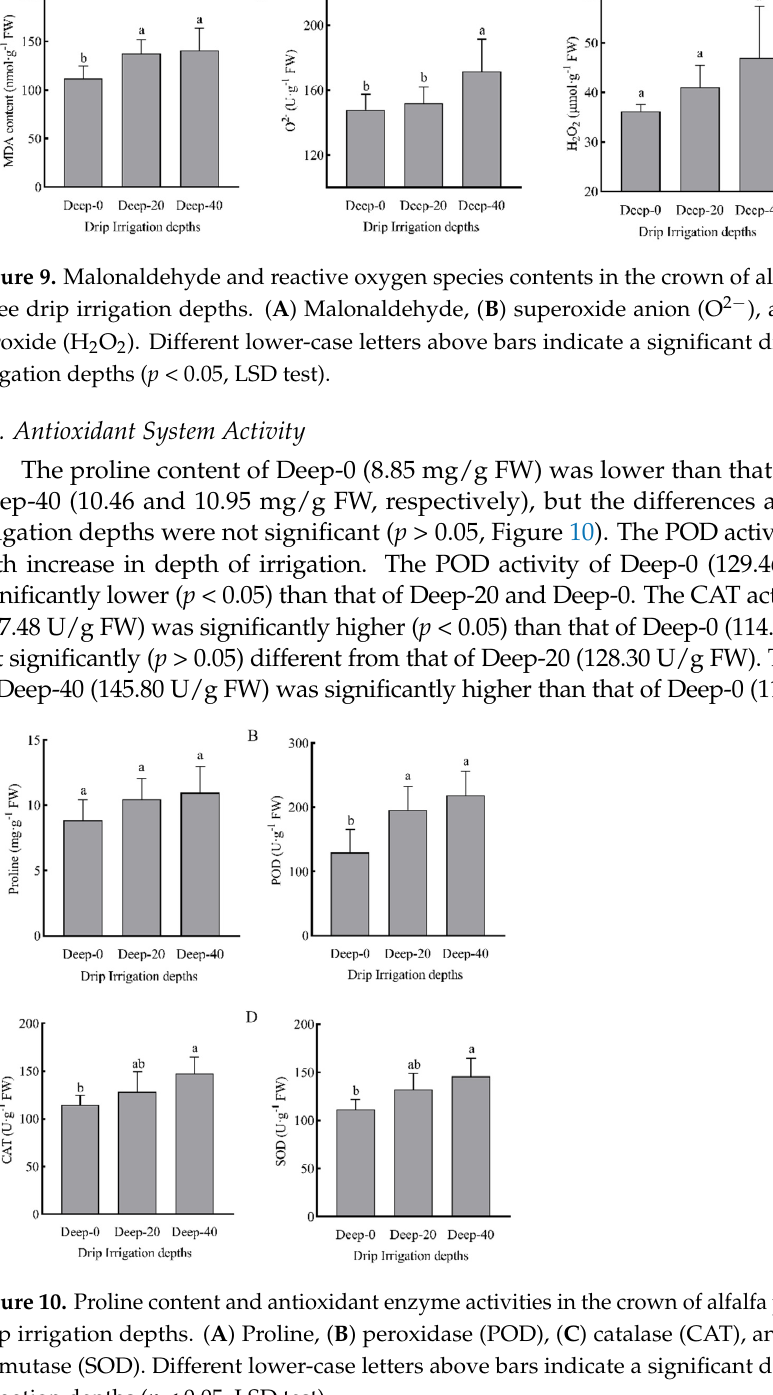
tween irrigation depths ( p < 0.05, LSD test). irrigation depths ( p < 0.05, LSD